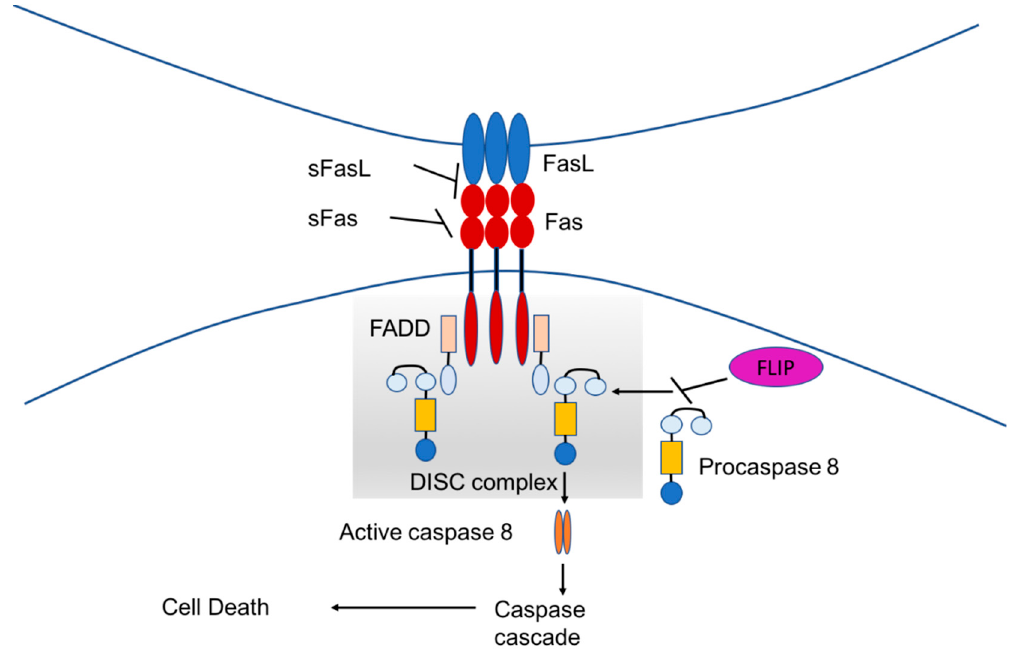
Figure 2. Schematic representation of the Fas/Fas-L pathway.